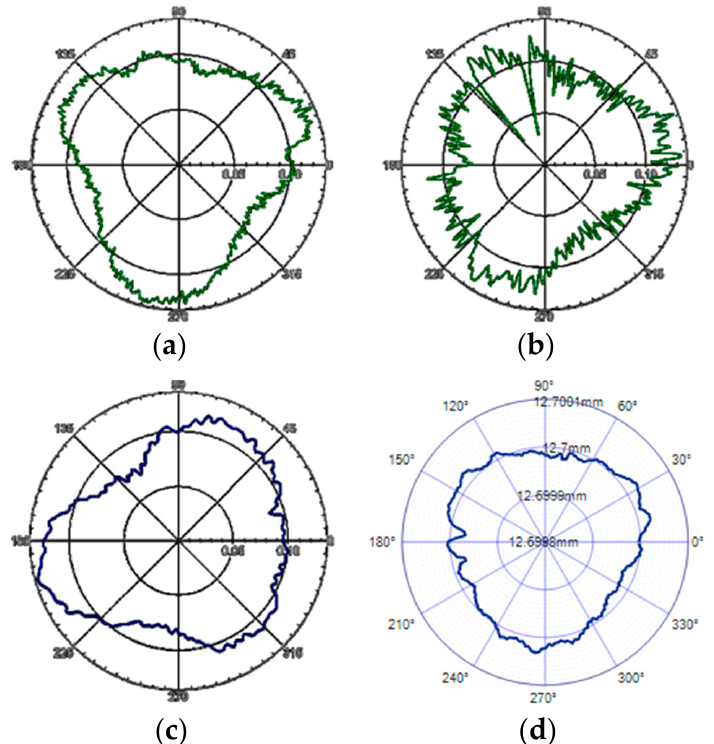
Figure 16. Comparison of different measurement objects ( a ) Roundness error for s1, ( b ) Roundness error for s2, ( c ) Roundness error for s3, ( d ) Roundness error for Turntable, (s1 is aerostatic spindle 1, s2 is aerostatic spindle 2, s3 is aerostatic spindle 3).